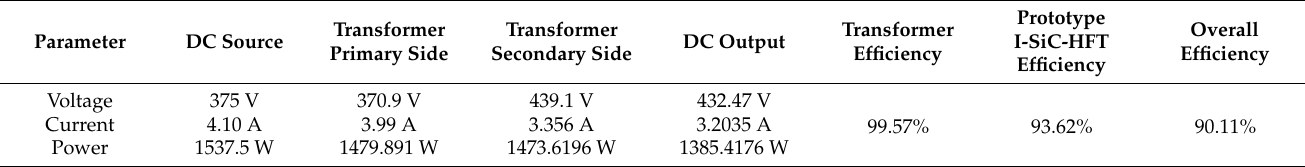
Table 11. Simulation results of the hard-switching DC–DC